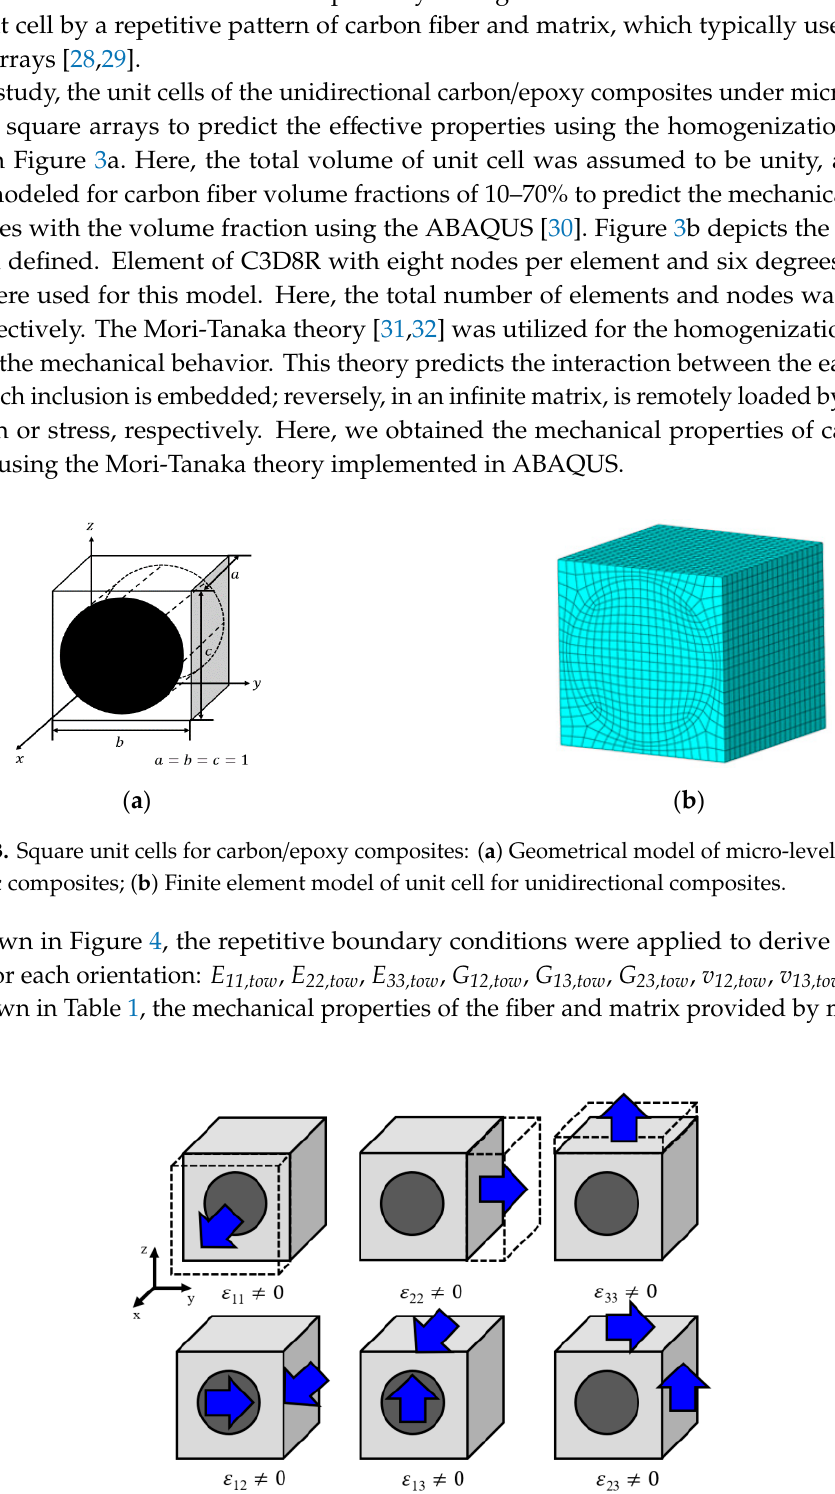
Figure 4. Schematic representation of the displacement boundary conditions required to estimate the equivalence elastic properties.